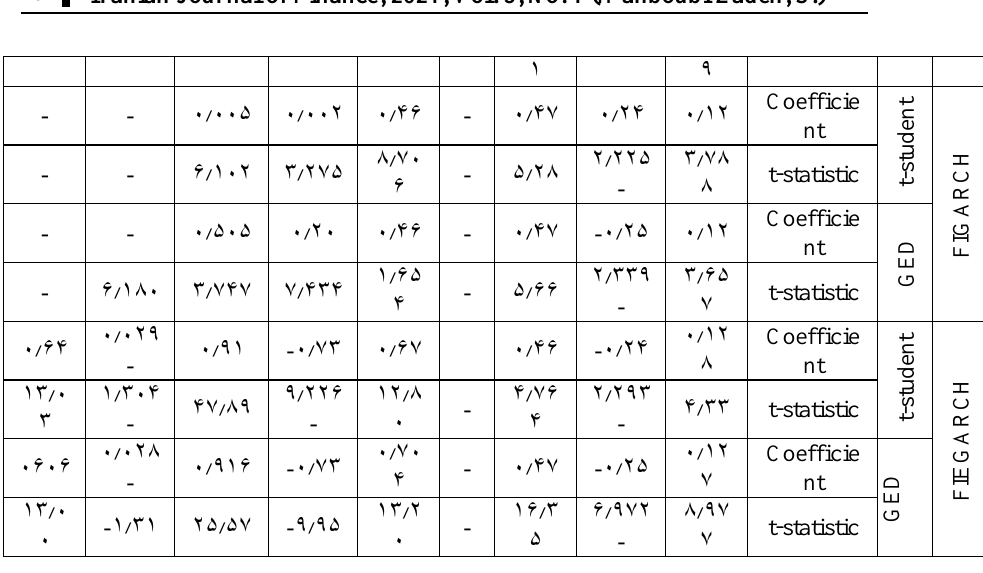
Table 8. Estimation of Markov switching mean models for three industries lacking